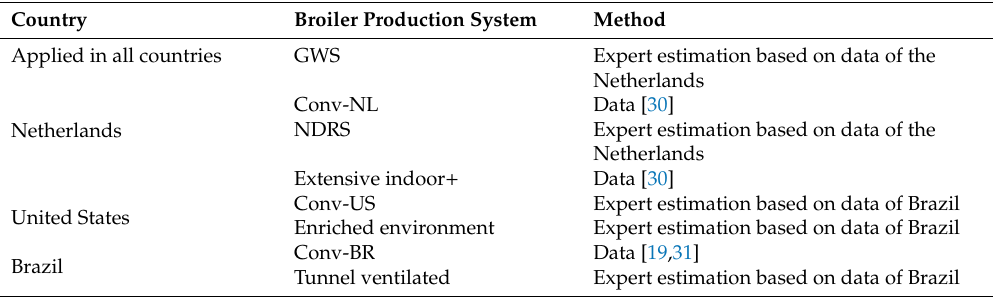
Table 3. Method applied for each production